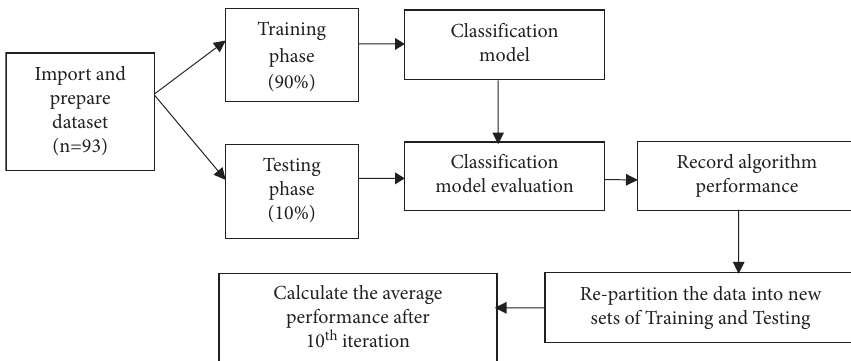
Figure 1: Flowchart of supervised machine learning with 10-fold cross-validation.